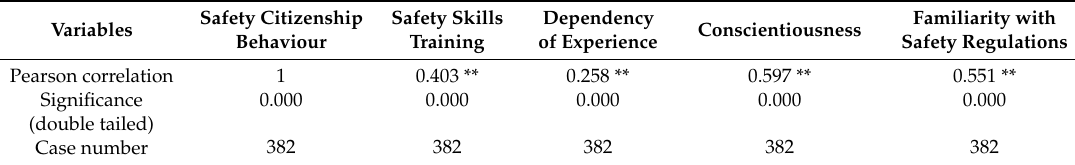
Table 9. Correlation analysis between safety citizenship behaviour and various dimensions of safety consciousness.